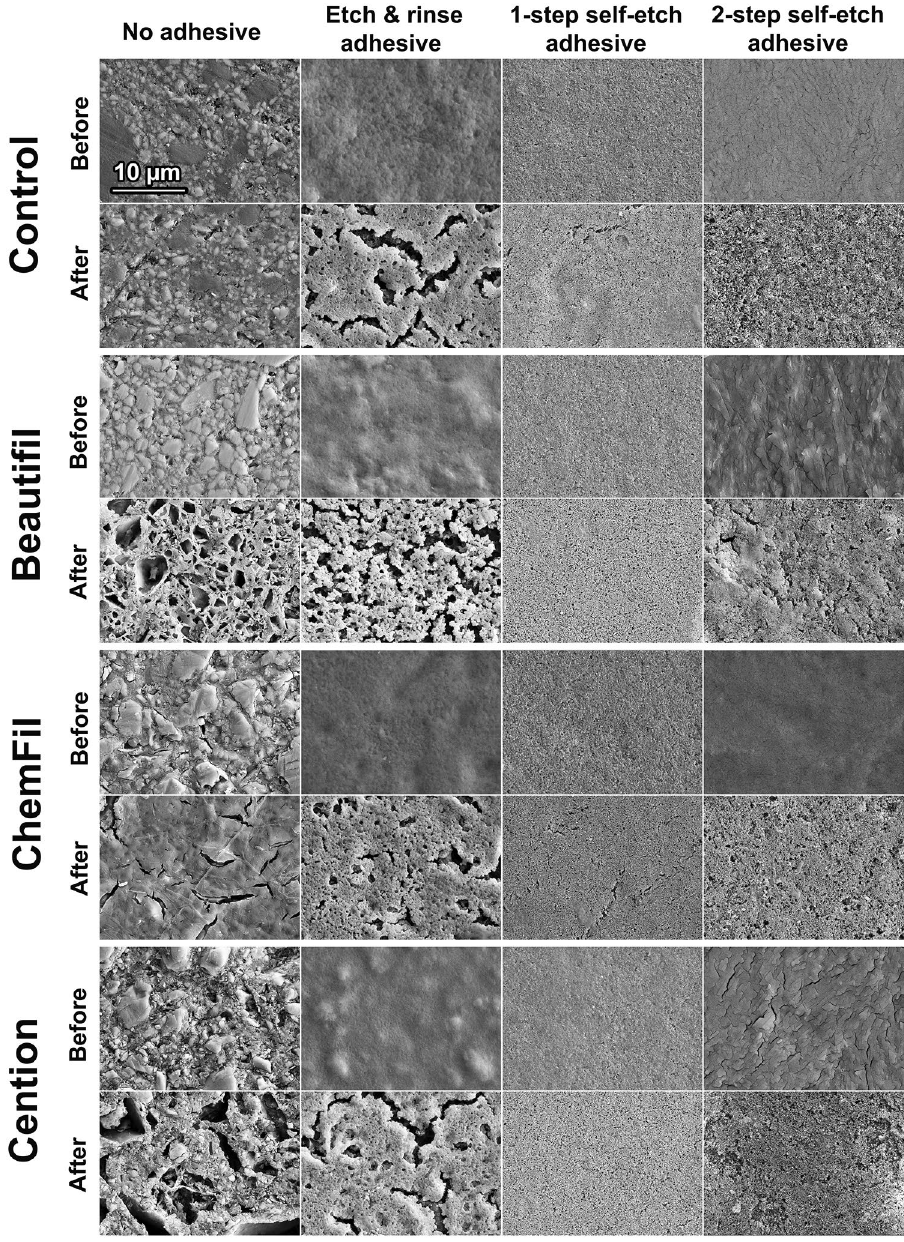
Figure 8. Scanning electron micrographs of the control composite and commercial restorative materials before and after 32 days lactic acid